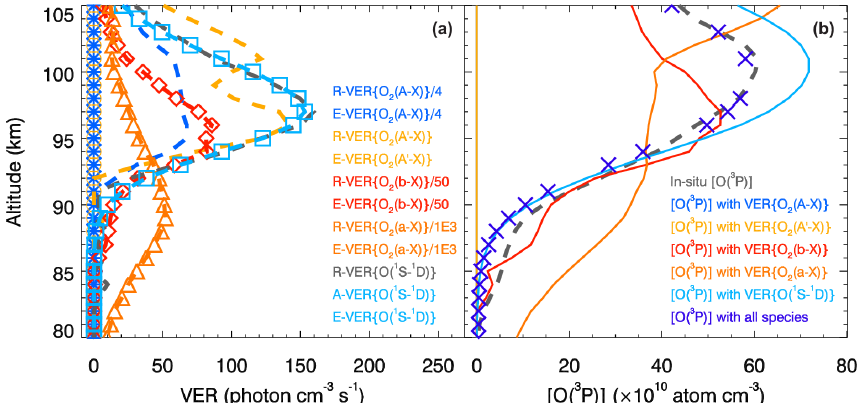
Figure 5. Similar to Figs. 3 and 4, but showing results obtained with the MAC model excluding O 2 (A) and O 2 (A (cid:48) ) . The first two retrieval steps 2.1 and 2.2 are not carried out, because now the VER { O 2 (A − X) } and VER { O 2 (A (cid:48) − a) } profiles are not considered in the MAC calculations. The in situ and retrieved VER and [ O ( 3 P) ] profiles obtained at steps 2.3, 3.2, 4.1 and 5.1 agree with each other by sight and with those shown in Fig. 4, and the MAC calculations are concluded to be verified and validated. The comparison of products related to VER { O ( 1 S − 1 D) } indicated by the cyan color and shown in this figure as well as in Fig. 3 enables the conclusion that the contribution of O 2 (A) and O 2 (A (cid:48) ) to the O ( 1 S) production is negligible. Therefore, O 2 (c) can be considered the major O ( 1 S) precursor. It follows also that the triplet Herzberg states ( A 3 (cid:54) + u , A (cid:48) 3 (cid:49) u ) are more strongly coupled with the triplet ground state ( X 3 (cid:54) − g ) than with the singlet